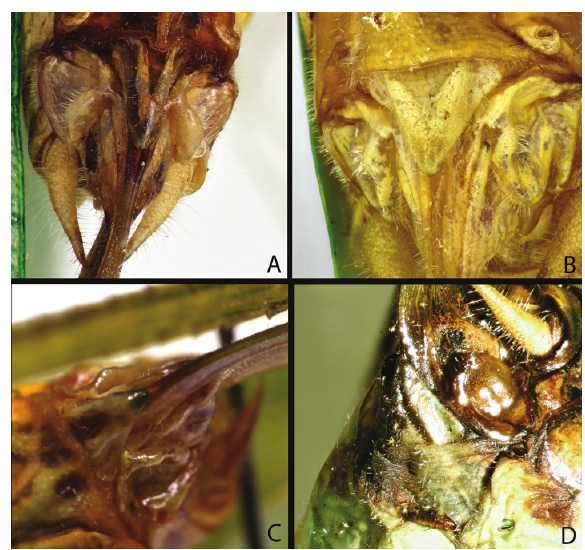
Figure 9. Subgenital plates of female Gonatoxia species. A.